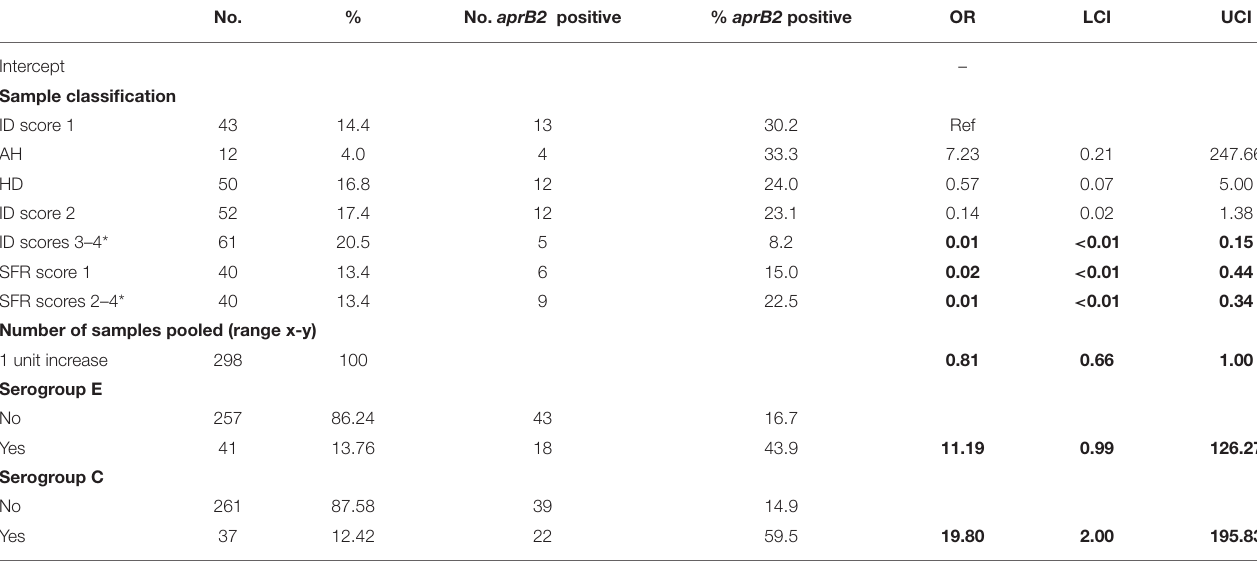
TABLE 4 | Binomial multivariable mixed effect regression model of pooled samples that were aprV2 only vs. aprV2 and aprB2 gene variants by footrot phenotype and serogroup in 298 samples from three visits to 24 sheep flocks in England. No. % No. aprB2 positive % aprB2 positive OR LCI UCI Intercept –